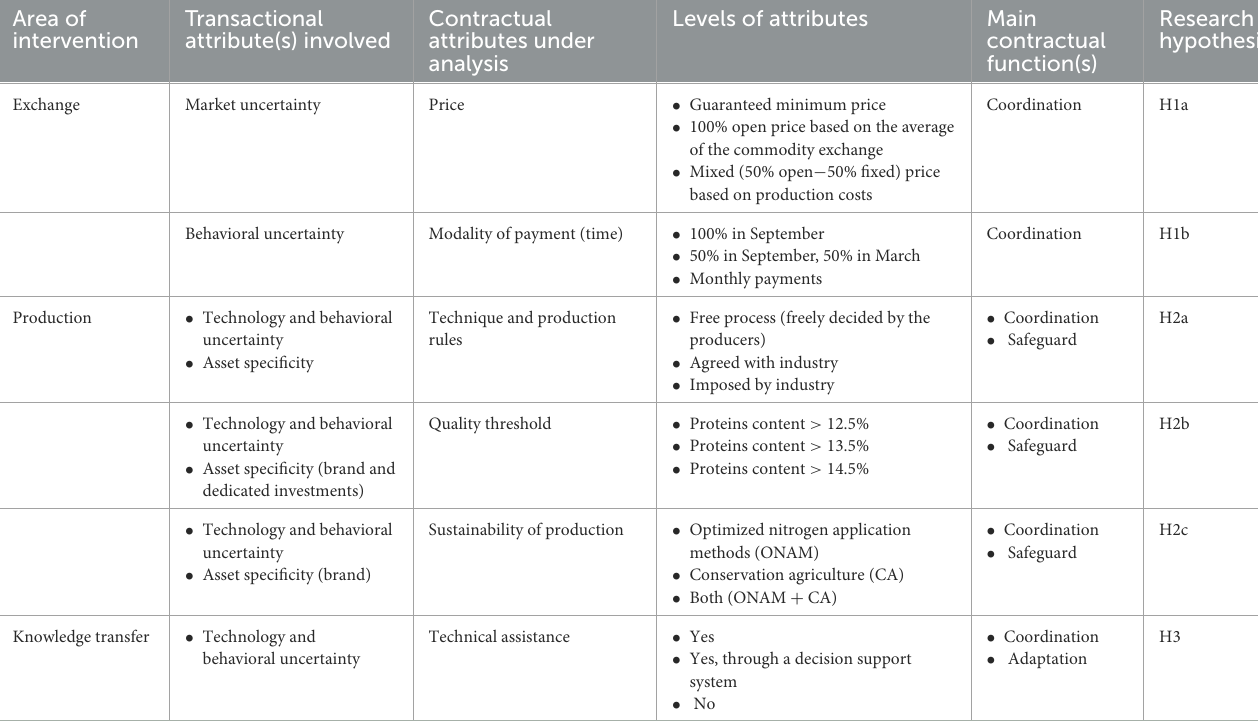
TABLE 1 Contract design: Concepts, areas of interventions, functions, and attributes.